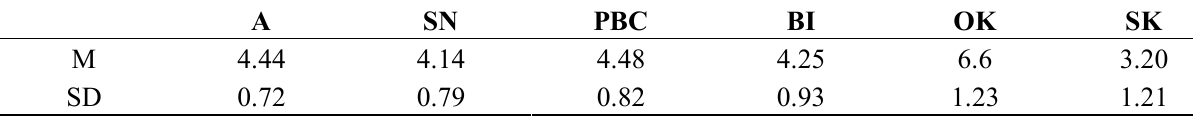
Table 1. The means and standard deviations of the latent